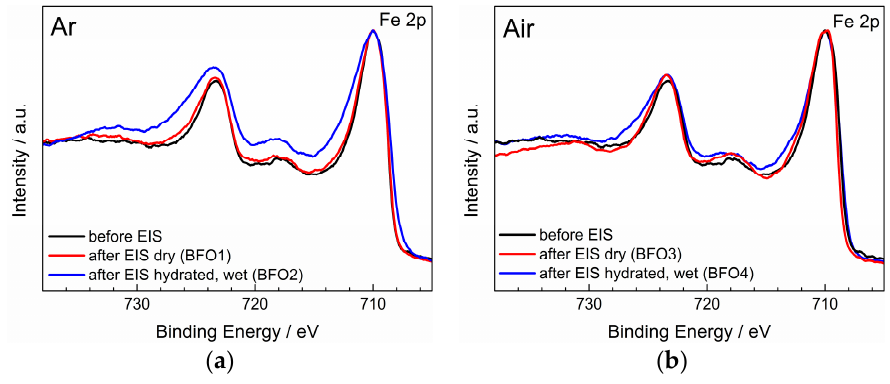
Figure 8. Comparison of Fe 2p spectra after EIS measurements in ( a ) Ar and ( b ) air.